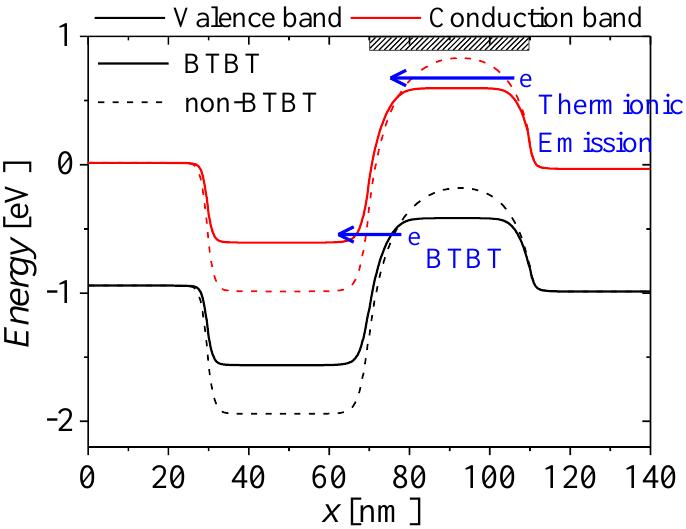
Figure 7 show the energy bands on surface region at V GS = 0 and V DS = 1 V when BTBT is considered and ignored. The red and black lines denote conduction and valence bands, respectively. As shown in Figure 7, the potential barrier and well is shifted by changing carrier concentrations in the channel region. The shallowed potential well produces more minority carrier diffusion current at V GS = 0 V. Therefore, the leakage currents increase when the BTBT is considered, as shown in Figure 4.